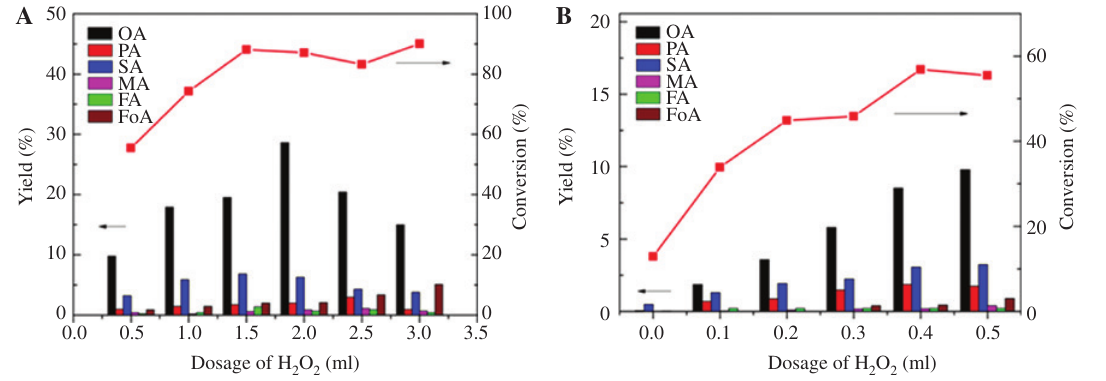
Figure 9: Effect of oxidation reaction: (A: large, B: small) the dosage of H